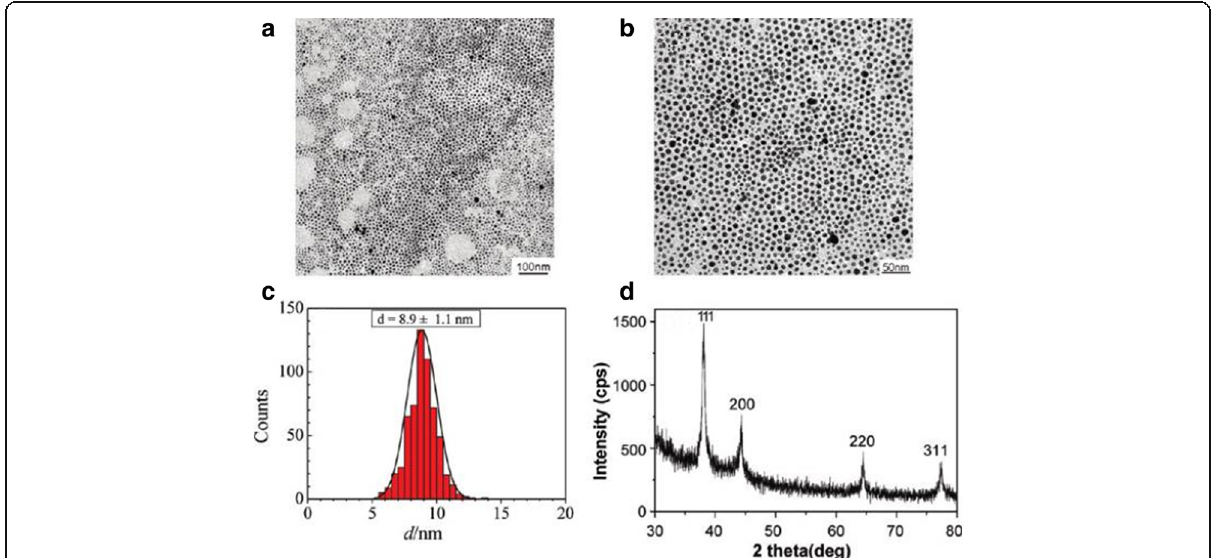
Fig. 7 a , b TEM images at two magnifications of silver nanoparticles collected from the reaction system after adding NaOH at 90 C for 1 h. c Corresponding histogram of the silver nanoparticles size distribution. d XRD pattern of silver nanoparticles [62]